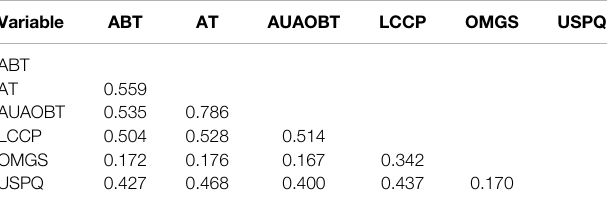
TABLE 3 | Fornell – Larcker criterion.